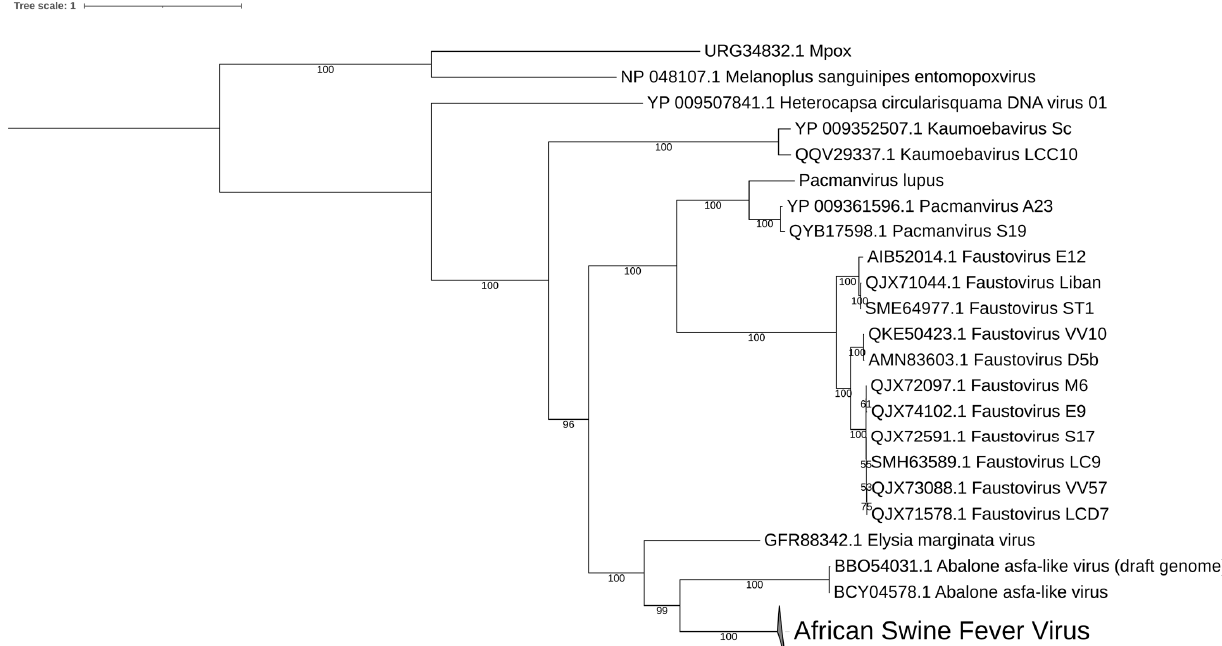
indicated below the sequence. The connected lines represent the relatively similar blocks between the genomes.